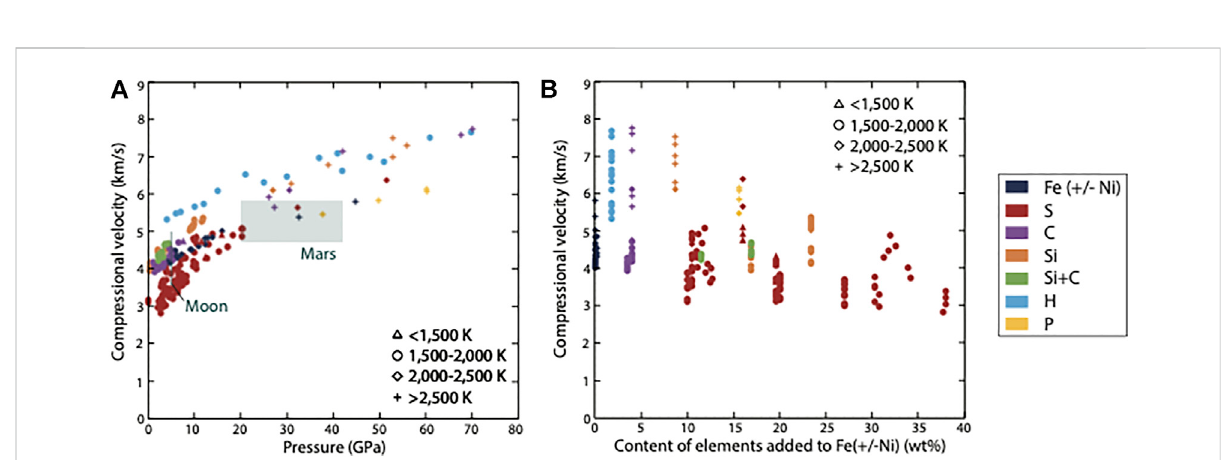
FIGURE 4 Compressional (P-wave) velocity of liquid iron and iron alloys from previous experimental studies as a function of pressure (A) and content of elements added to Fe or Fe+Ni (B) for different temperatures. Vp estimates for the core of Mars and the Moon are indicated with shaded areas. For Fe-H alloys, data only exist in the solid state, and therefore the bulk sound velocity is shown (see text for details). Data source: Jing et al., 2014;